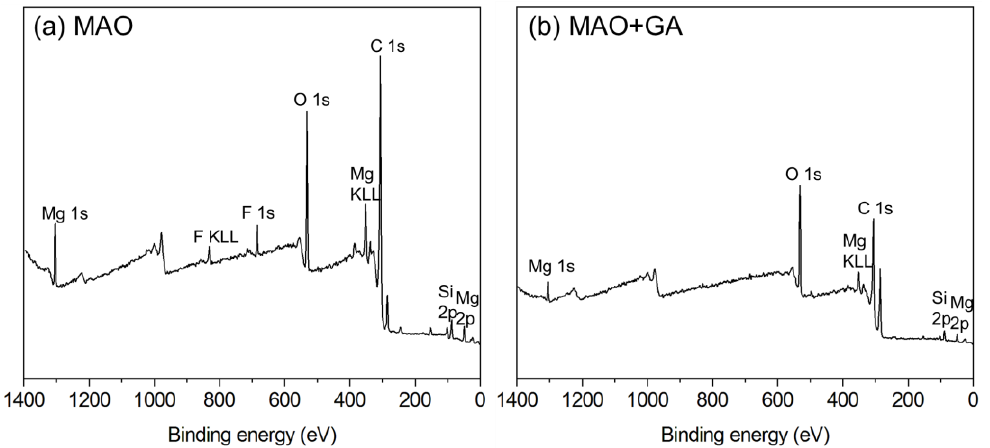
Figure 3. XPS spectra of ( a ) MAO and ( b ) MAO+GA coating.